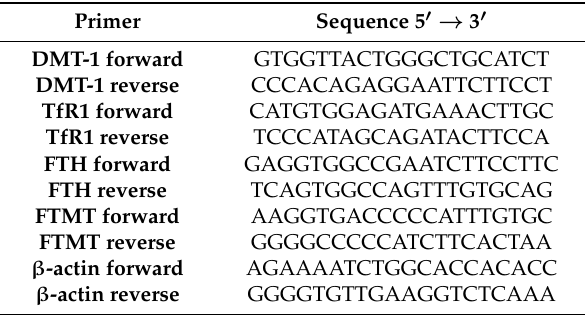
Table 1. Real-time PCR gene primer